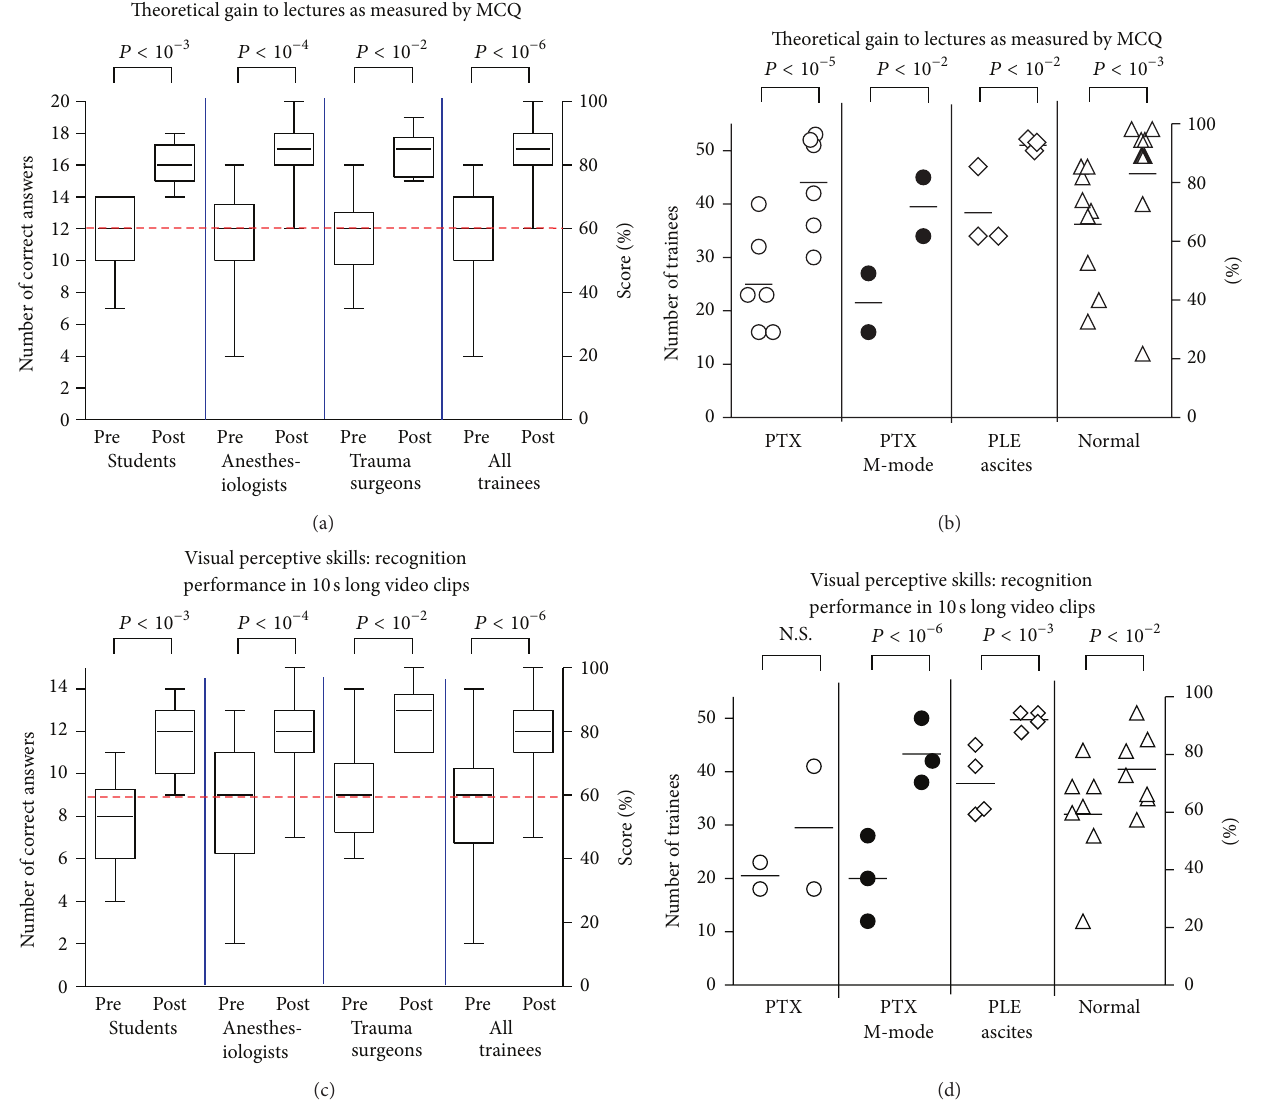
Figure 3: (a) Theoretical learning results of individual trainees and test groups assessed with MCQ in a pre-course (Pre) and post-course (Post) testing. Box plots represent the 25th and 75th percentiles with median. Dashed line indicates an arbitrary defined pass level of 60% (b) Number of trainees who correctly answered MCQ. Each symbol represents an independent question sorted by related categories. (c) Test for visual perceptive skills, where trainees had to identify characteristic physiologic or pathologic ultrasound findings, each shown in a 10sec video clips. Dashed line indicates an arbitrary defined pass level of 60%. (d) Numbers of trainees who obtained a correct answer during visual perceptive skill test. Each symbol represents a video-clip sorted by related